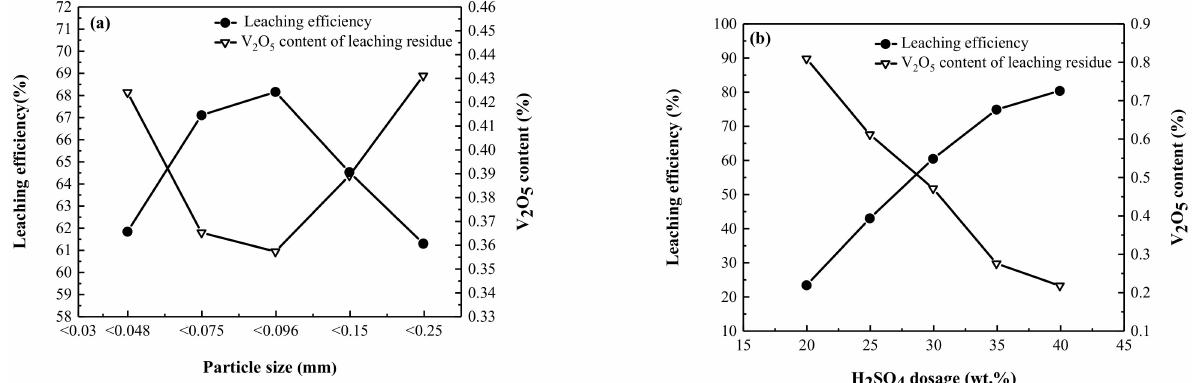
Figure 4. Effects of ( a ) particle size of Vanadium Ore and ( b ) H 2 SO 4 dosage on vanadium